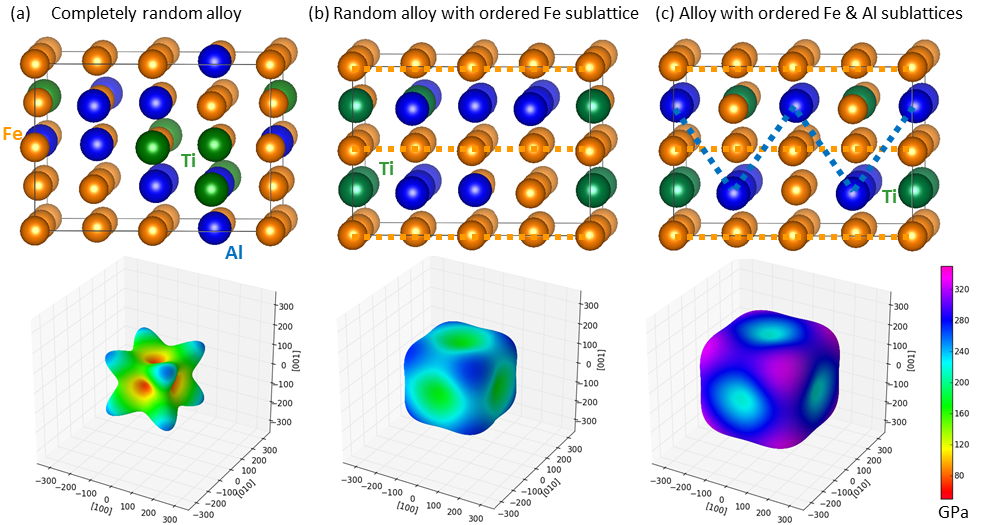
Figure 3. ( Upper row ) Schematic visualization of the employed 32-atom computational supercells with the chemical composition Fe 62.5 Al 25 Ti 12.5 (20 atoms of Fe, 8 atoms of Al and 4 atoms of Ti). These structures are used for modeling the phase of cuboids for which the equilibrium composition was determined to be Fe 66.2 Al 23.3 Ti 10.5 . The supercells differ in the distribution of atoms (see text). Yellow and blue dashed lines indicate ordered sublattices as in stoichiometric Heusler structure. ( Lower row ) Visualization of the anisotropic elastic properties for each atomic distribution in the form of directional dependences of the Young’s modulus (using the SC-EMA software [51,52],